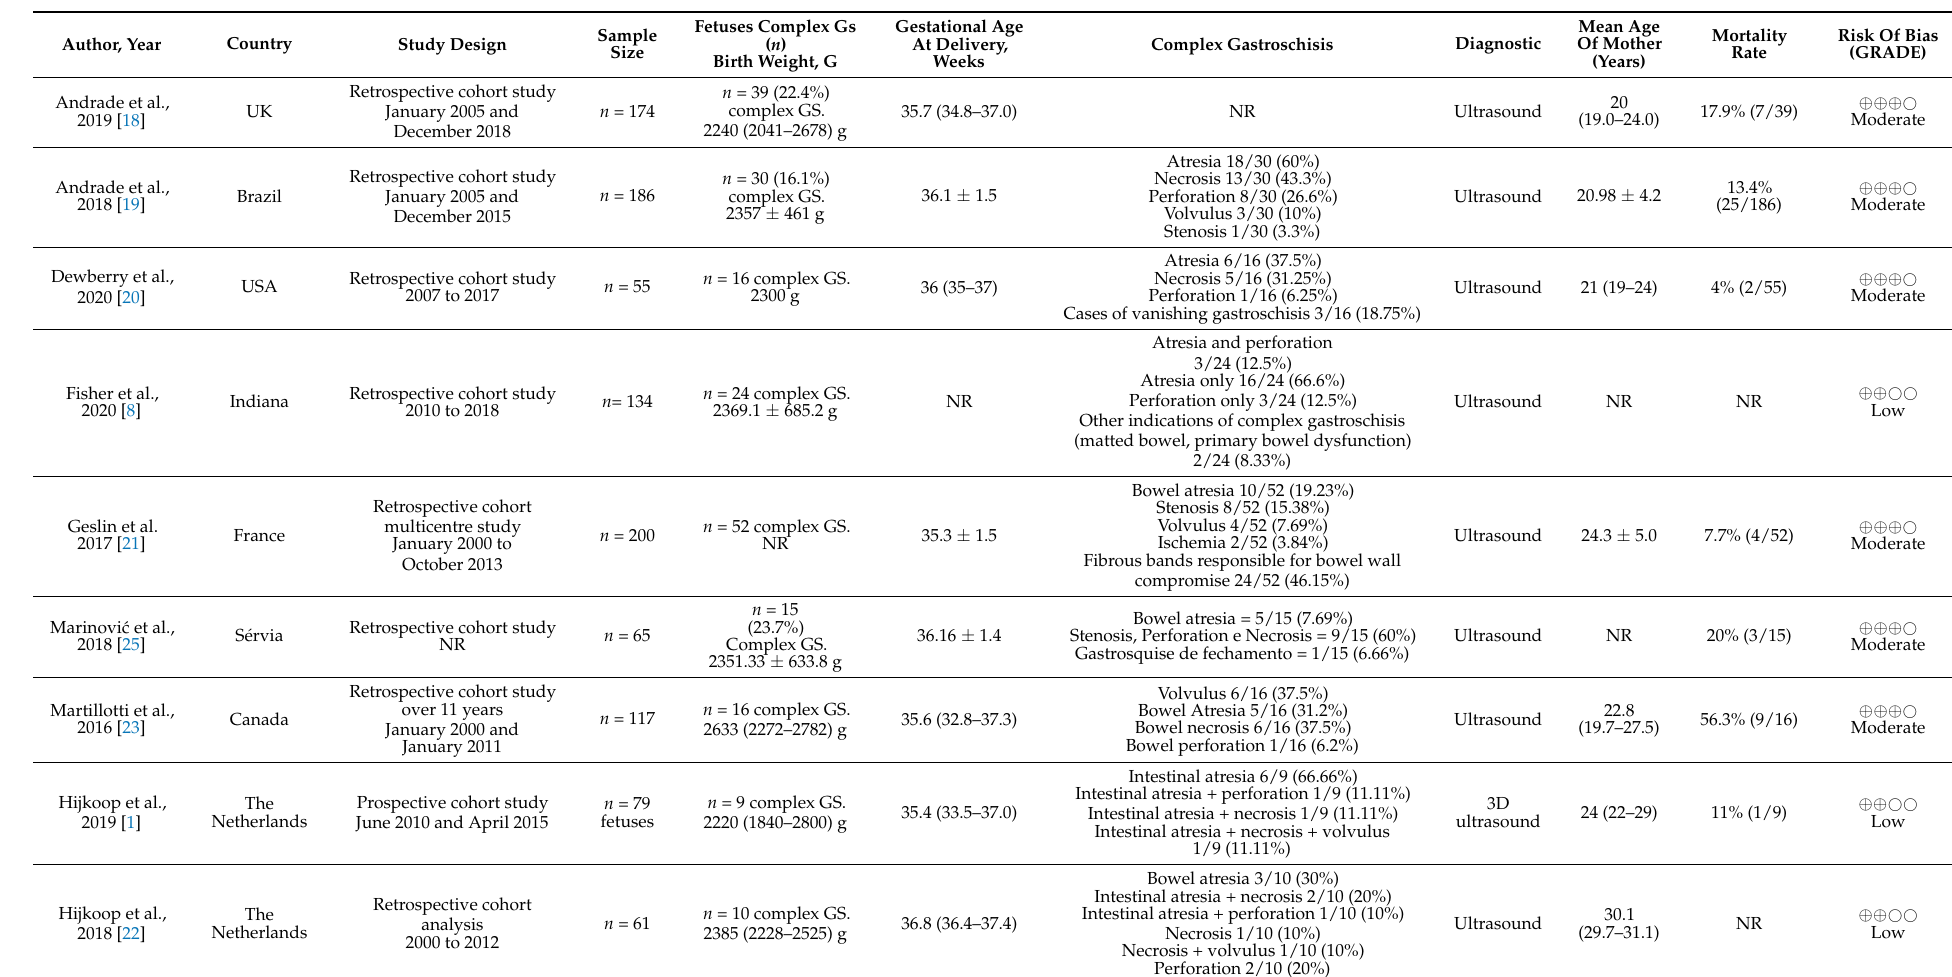
Table 1. Characteristics of studies included in the systematic